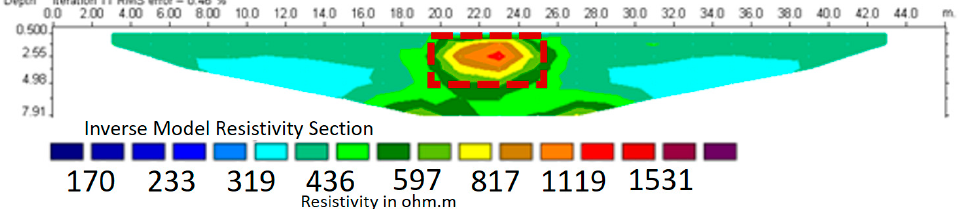
Figure 8. Numerical simulation result.